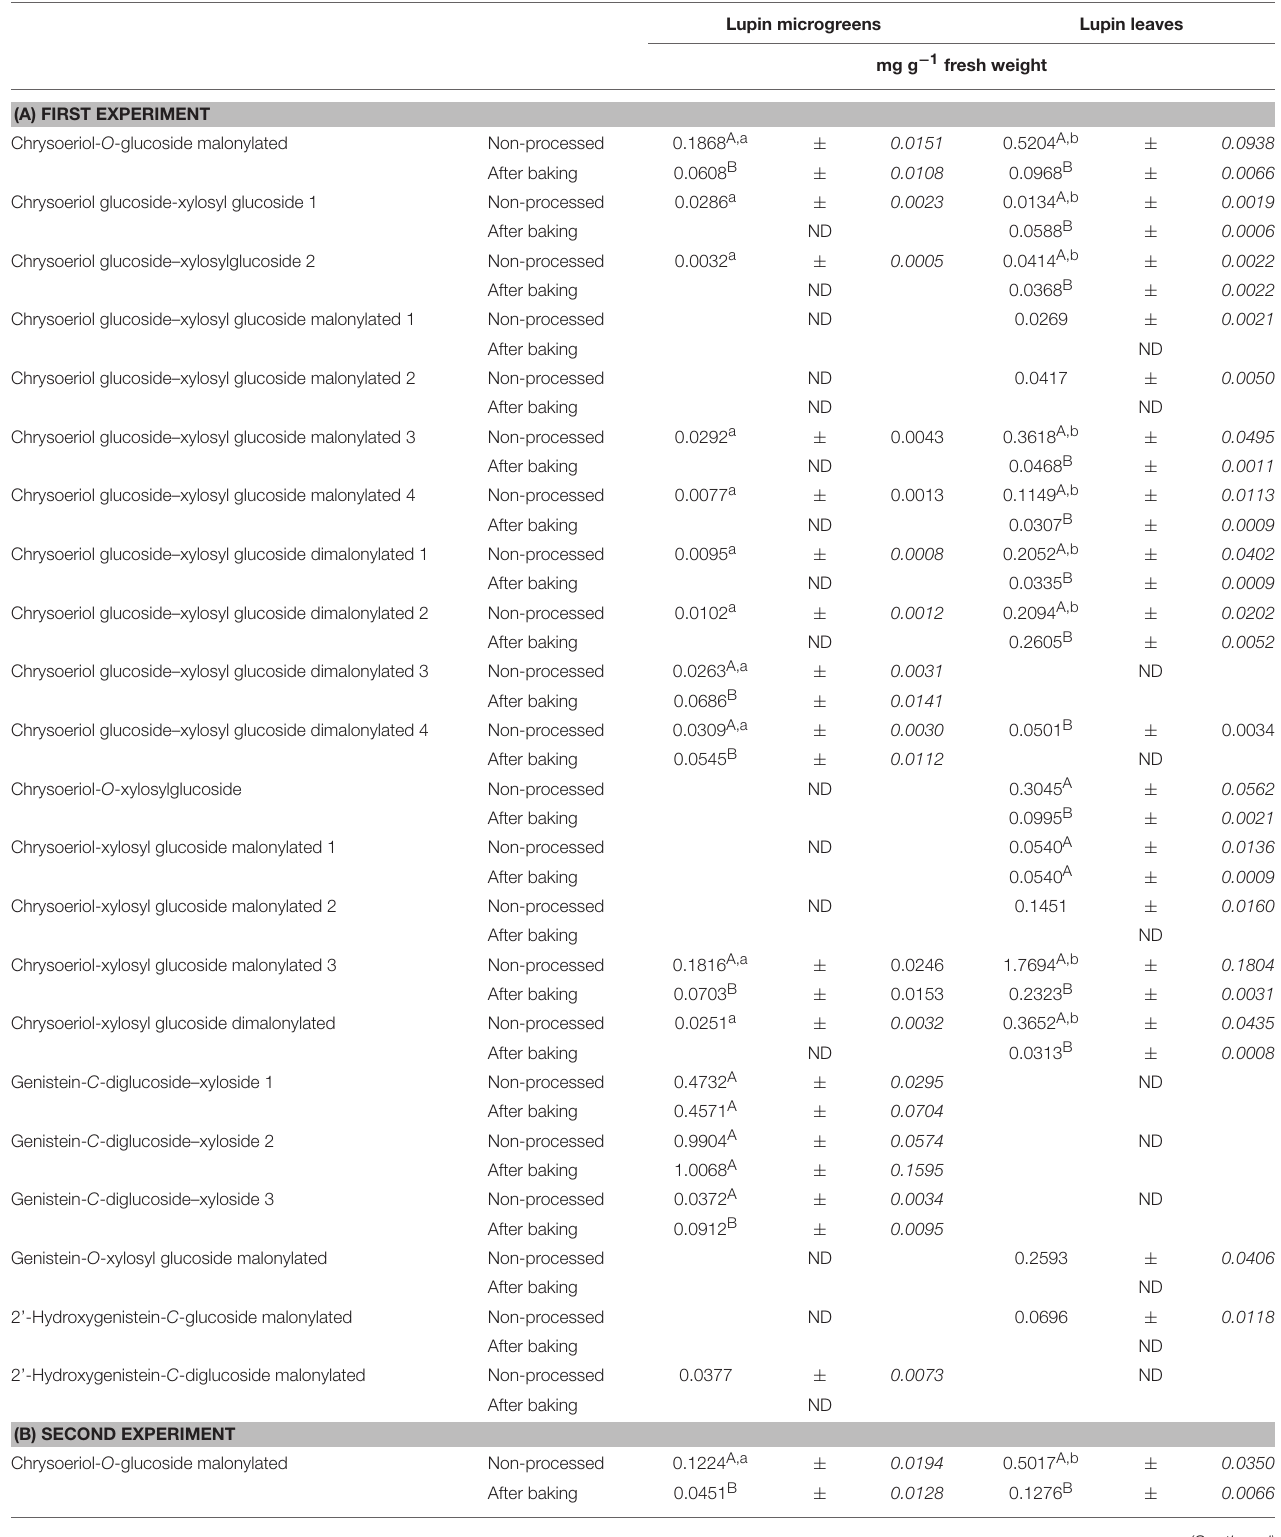
TABLE 2 | Average flavonoid concentration in lupin microgreens (7 d) and lupin leaves (14 d): Non-processed and in the lupin fortified bread. Lupin microgreens Lupin